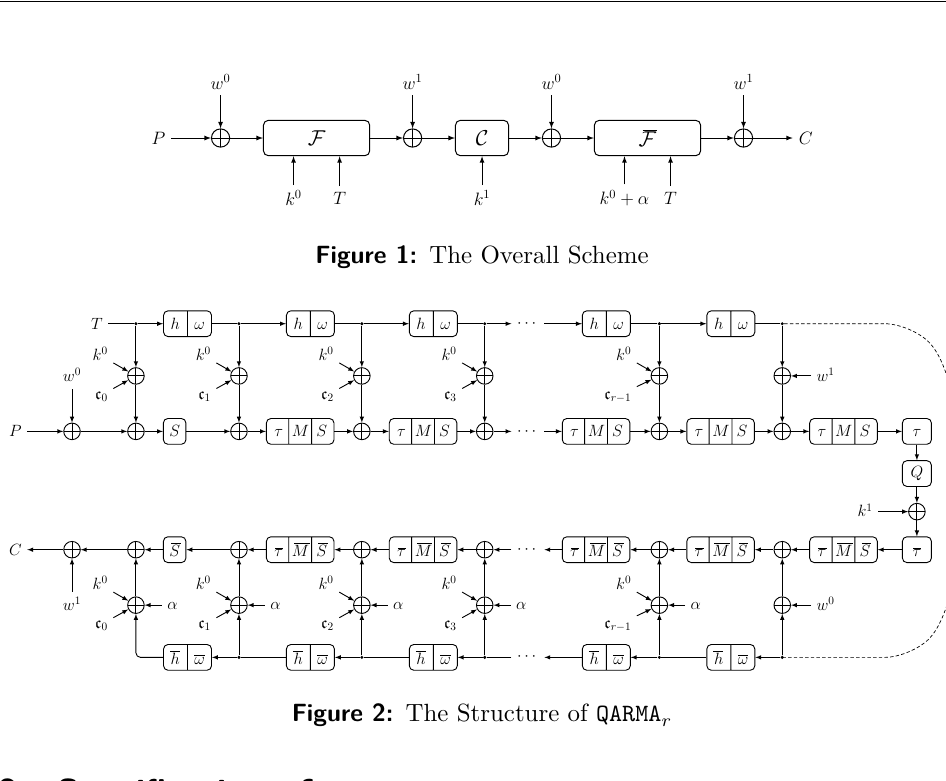
Figure 2: The Structure of QARMA